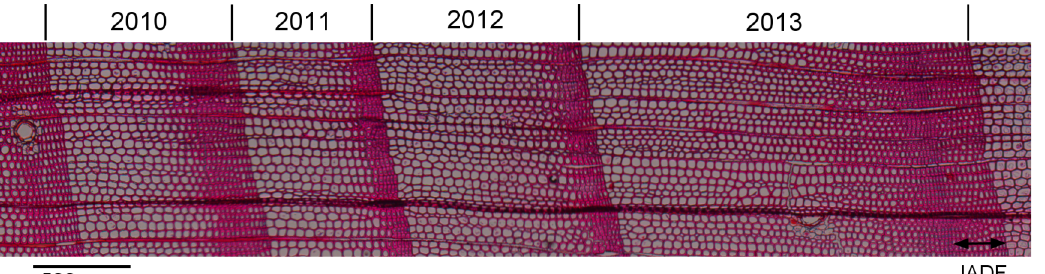
Fig 2. Tree rings of Pinus pinaster for the period 2010 – 2013, with the ring produced in 2013 showing an intra-annual density fluctuation (IADF) in